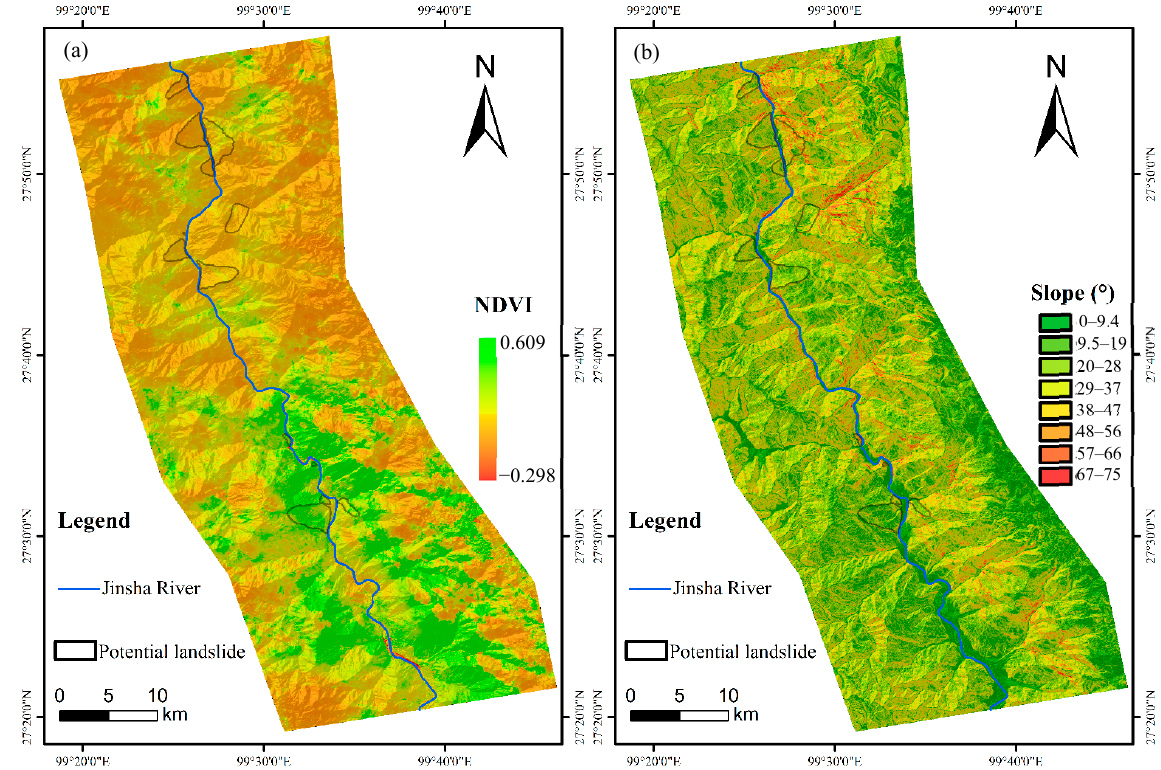
Figure 3. ( a ) Distribution of potential landslides interpreted from ALOS-2 data and ( b ) distribution of potential landslides interpreted from Sentinel-1A data.